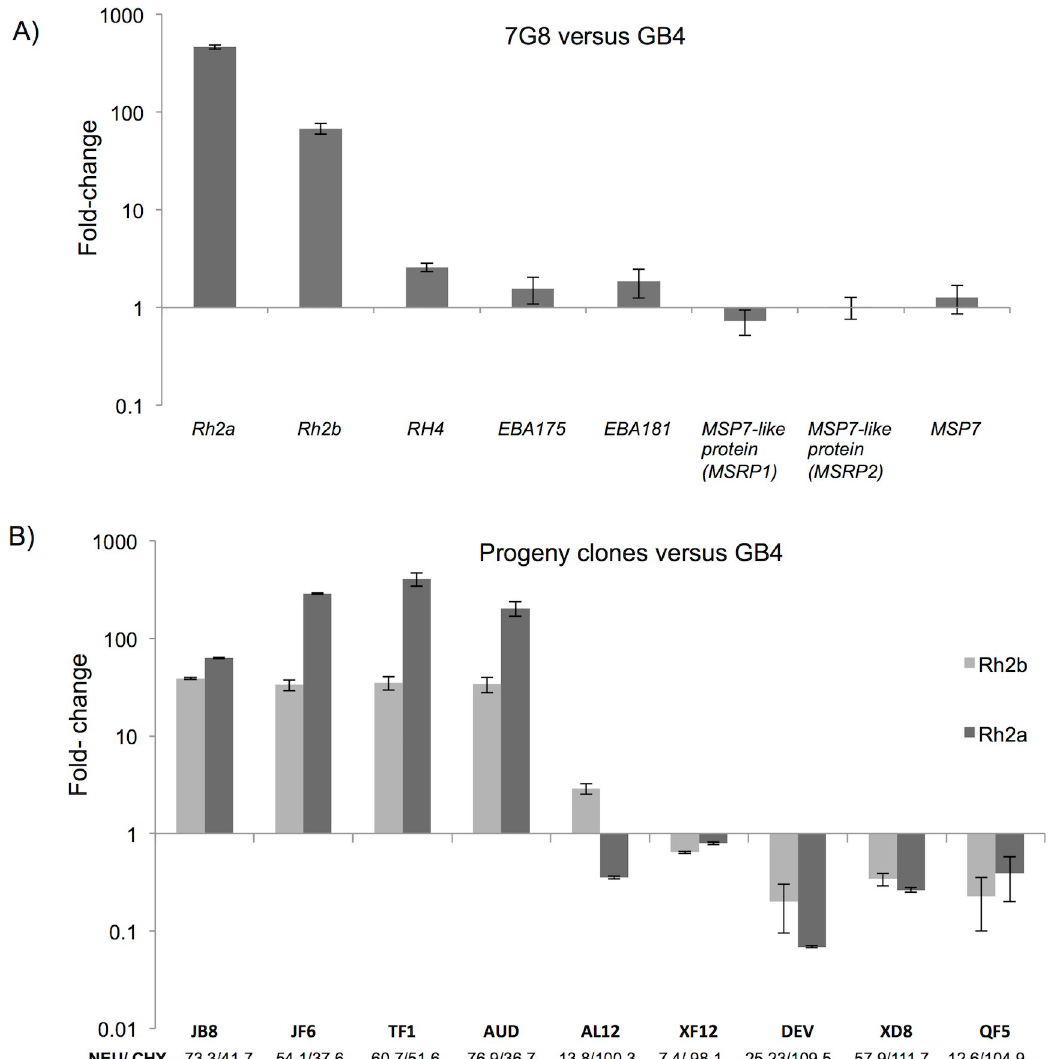
Fig 4. Relative transcript levels of genes mapping at the QTL on chromosome 13. (A) qRT-PCR data from the two parental strains, 7G8 and GB4, measuring expression of five genes expressed during schizont stage and present within the QTL associated with CHY and NEU invasion phenotypes ( PfRh2a , PfRh2b and 3 genes from the PfMSP7 family). Two invasion related genes ( PfEBA175 , PfEBA181 ) were tested as controls. Expression of all genes was normalized to PfAMA1 . (B) Expression of PfRH2a and PfRh2b in nine progeny clones, four in which invasion is affected by CHY treatment (JB8, JF6, JE1, AUD) and five where CHY has no effect on invasion (AL2, XF12, DEV, XD8, QF5). Expression was measured using qRT-PCR as above, and is displayed relative to expression in the GB4 parental line. Mean invasion rates for each progeny into NEU/CHY treated erythrocytes are listed under the clone name.